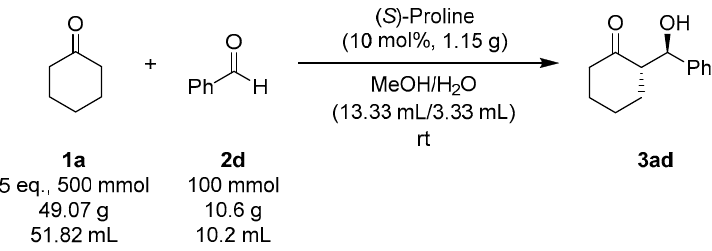
Table 6. Process scale-up study 1